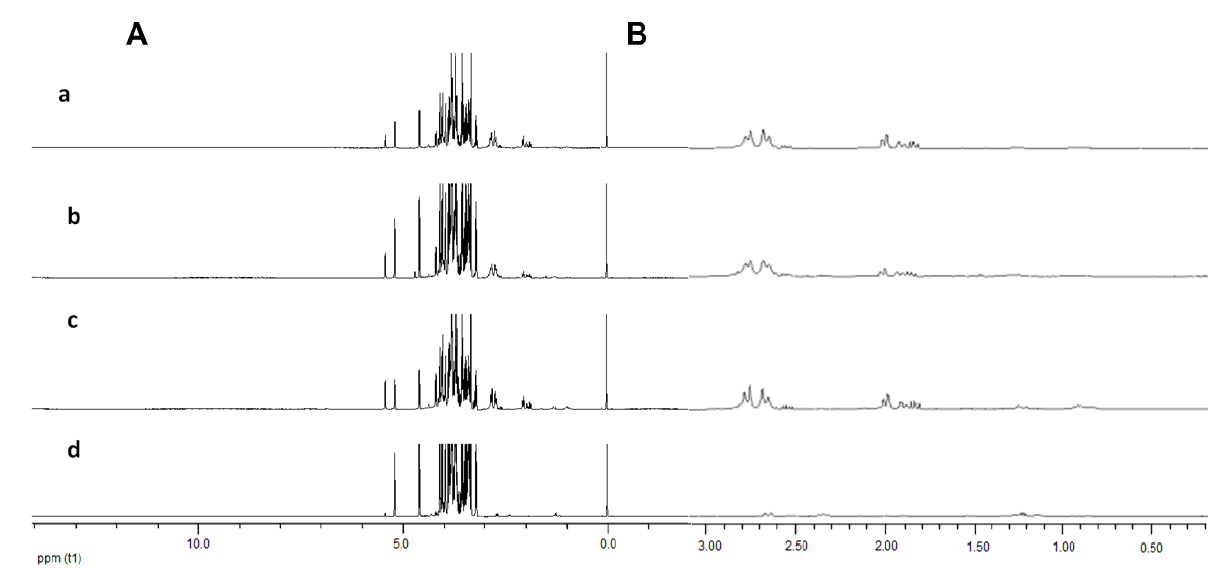
Figure 2. ( A ) The representative 1 H-NMR spectra in the δ 3.00 to 5.00 range of kiwifruits ( a ) Hayward, ( b ) Bidan, ( c ) A. arguta and ( d ) persimmon Fuyu; ( B ) the representative expanded 1 D-NMR spectra in the δ 0.02 to 3.00 range from top to bottom: Hayward, Bidan, A. arguta and persimmon Fuyu.